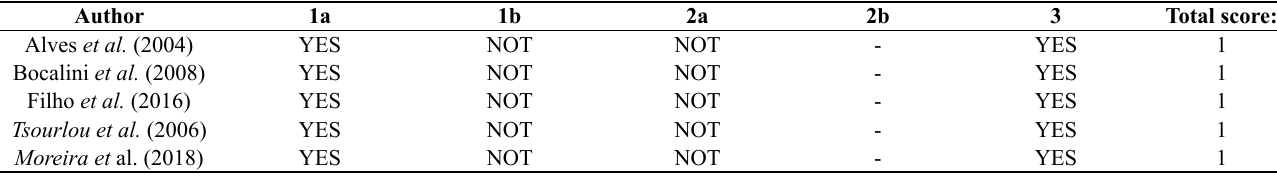
Table 2. Methodological quality of the studies analyzed through the Jadad Scale (30)